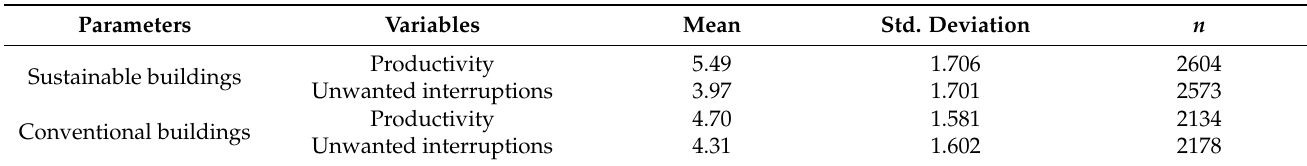
Table 7. Descriptive statistics of productivity and unwanted interruptions in sustainable and conventional buildings.